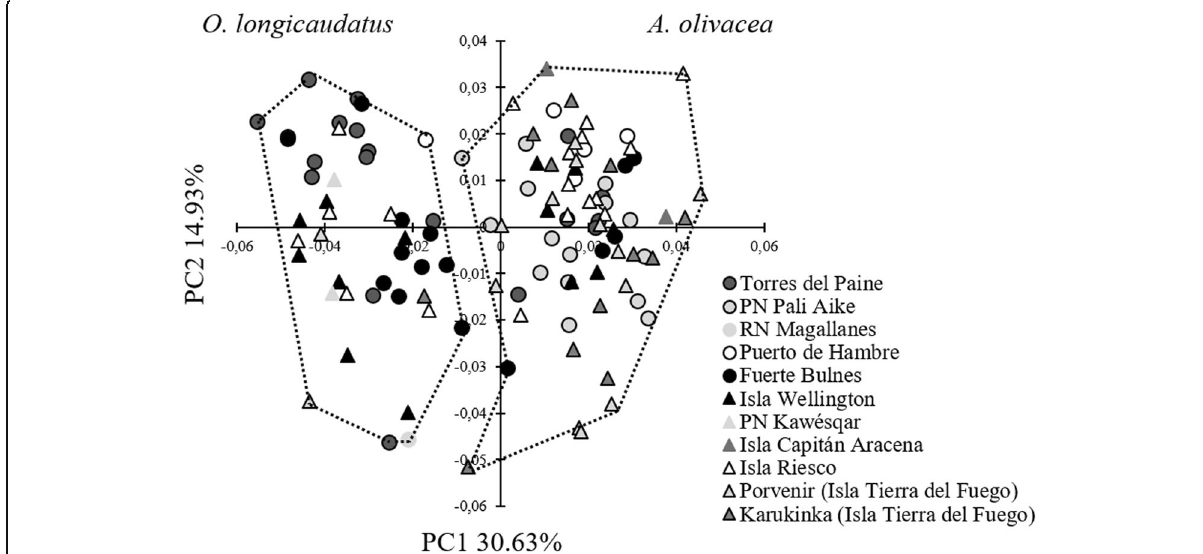
Fig. 5 Principal Component Analysis of the geometric morphometric approach along the Principal Components 1 and 2 (PC). Both species are displayed along the axes. PN = Parque Nacional, RN = Reserva Nacional, circles = mainland localities, triangles = insular